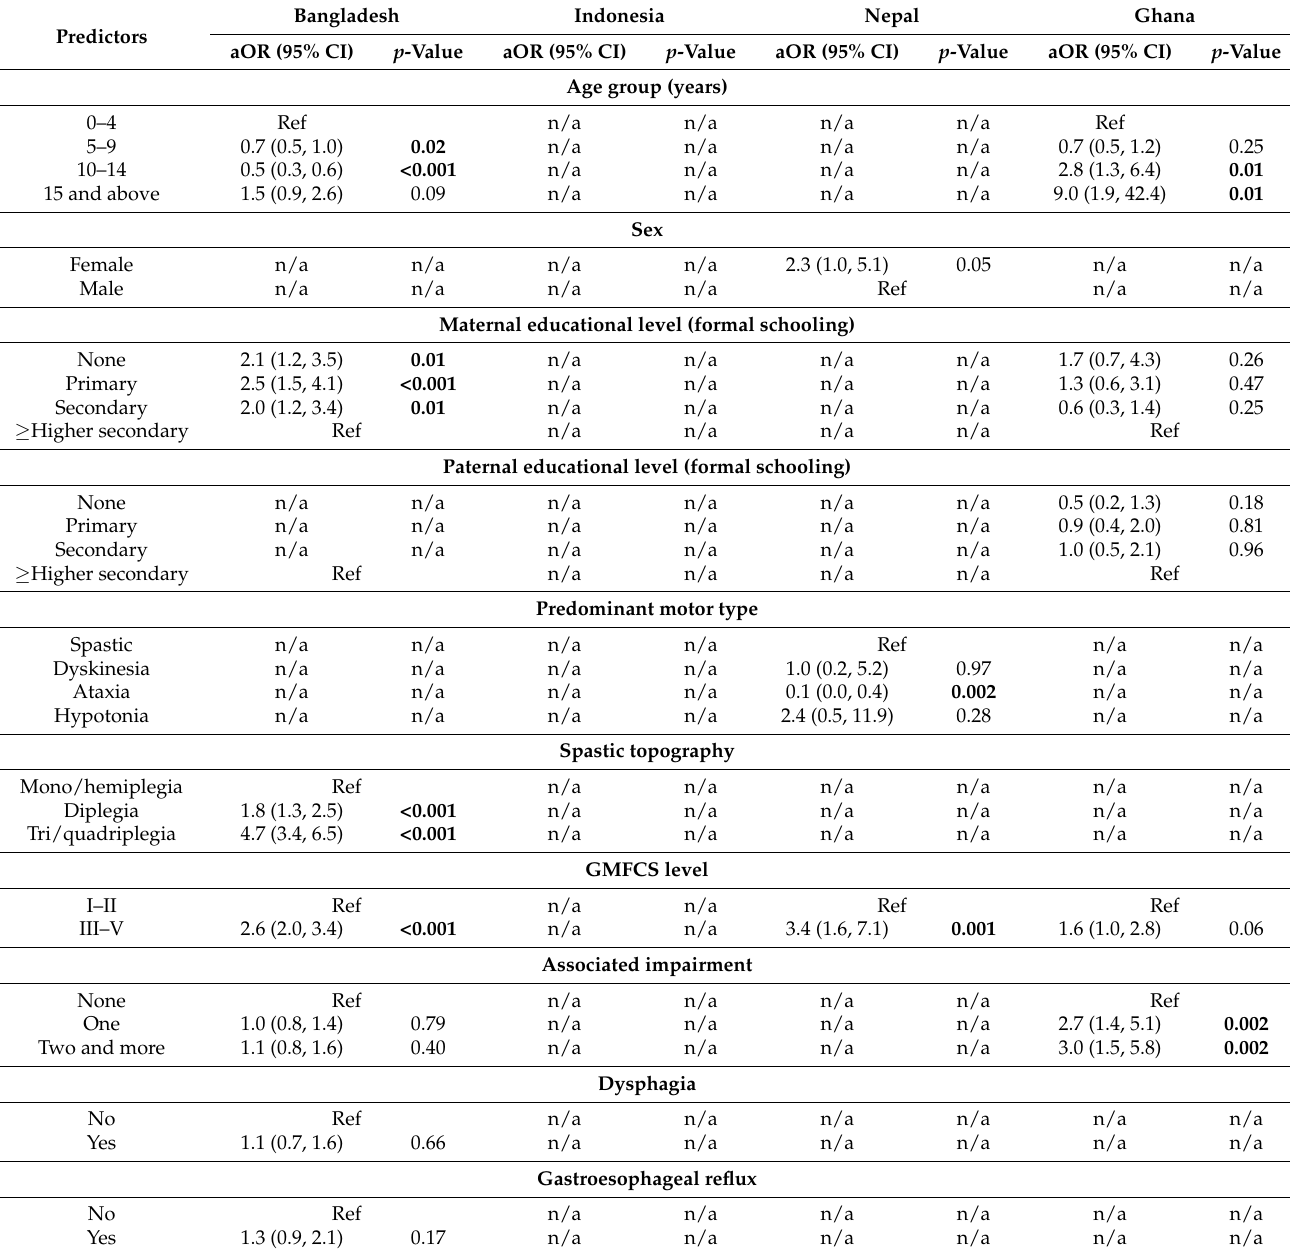
Table 5. Predictors of stunting (HAZ < − 2SD) among children with CP registered in the GLM CPR (adjusted odds